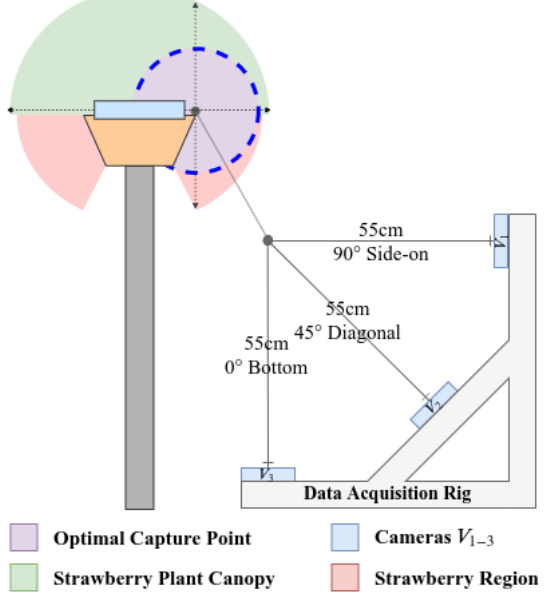
Figure 1. Camera configuration for viewpoints V 1 , V 2 and V 3 , where V 1 − 3 are camera identifiers.